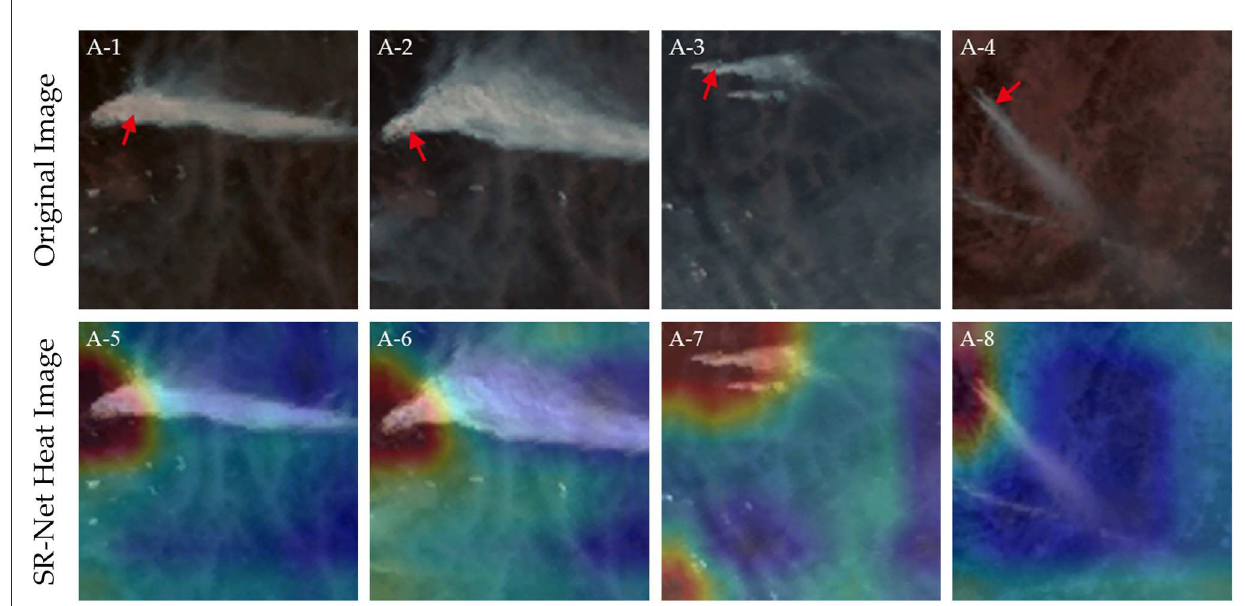
FIGURE8 Examples of some unusual conditions of visualizations based on the SR-Net. The (Top) row shows the original forest fire smoke images, and the (Bottom) row shows heat images processed by Grad-CAM based on the SR-Net. The attention distribution when the model detects forest fire smoke is marked with blue, yellow, and red in descending order of weight from high to